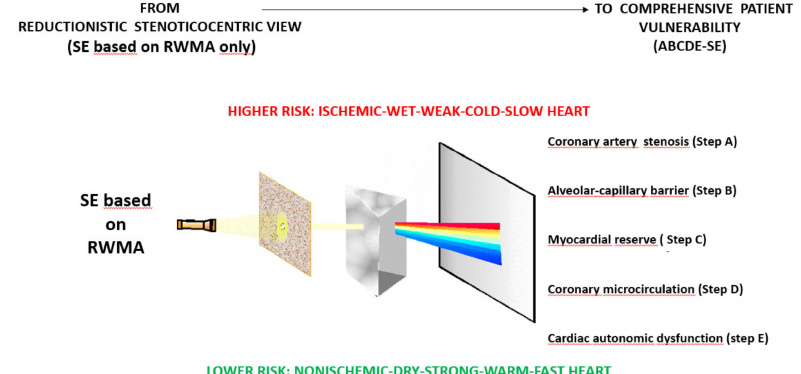
Figure 2. The prognostic approach with advanced SE. Left panel: in the classical or conventional SE approach risk stratification is based only on the presence and extent or regional wall motion abnormalities, which o ff ers a limited measure of risk. Right panel: the advanced ABCDE protocol acts as a Newton’s prism that o ff ers a multi-dimensional response that includes regional wall motion, pulmonary congestion, preload and afterload reserve, coronary microcirculation, and sympathetic reserve. Each color identifies a specific vulnerability and is a possible target for selective therapeutic